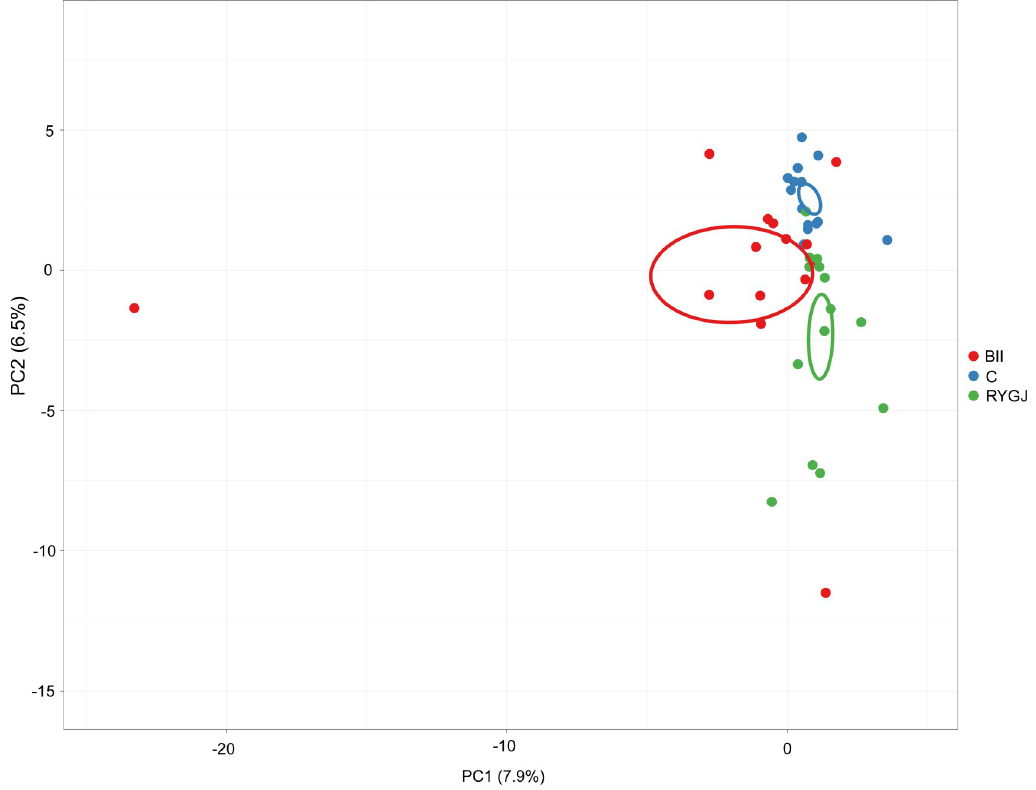
Fig 2. Principal component analysis of bacterial genera abundance. Principal component analysis of bacterial genera abundance showed a clear separation between control and BII or RYGJ groups. C, control; BII, subtotal gastrectomy with Billroth II anastomosis; RYGJ, subtotal gastrectomy with Roux-en-Y gastrojejunal